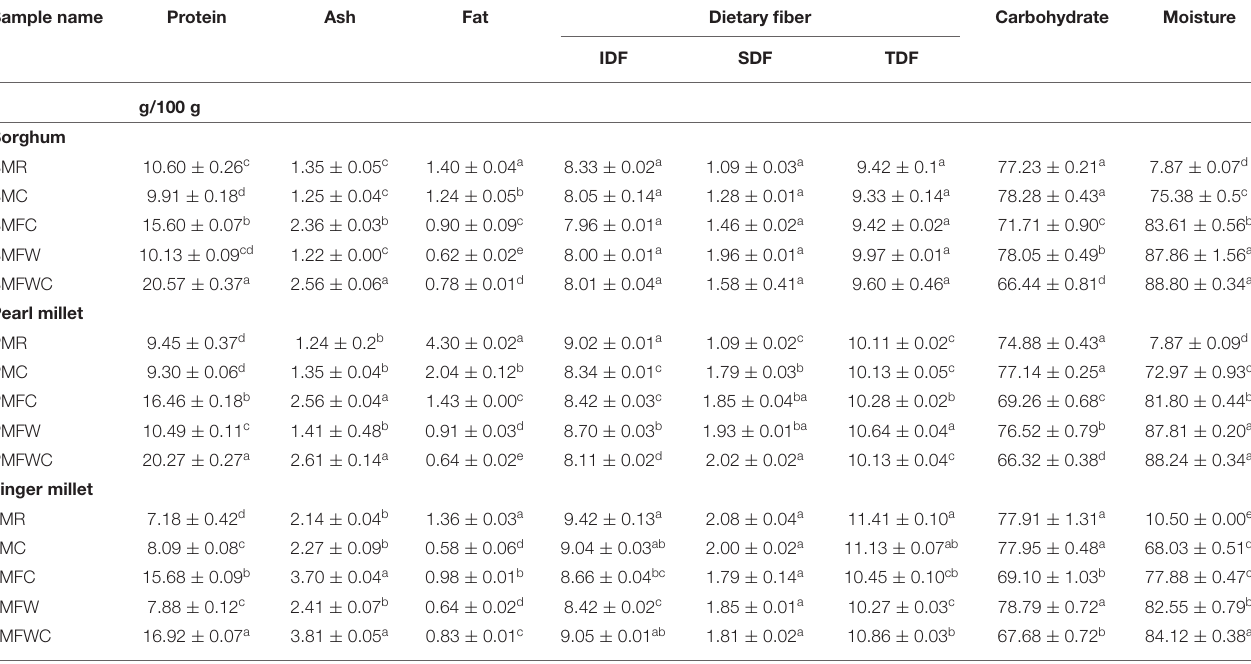
TABLE 1 | Proximate principles of raw and traditionally processed sorghum, pearl millet, and finger millet (g/100g) in dry weight except for